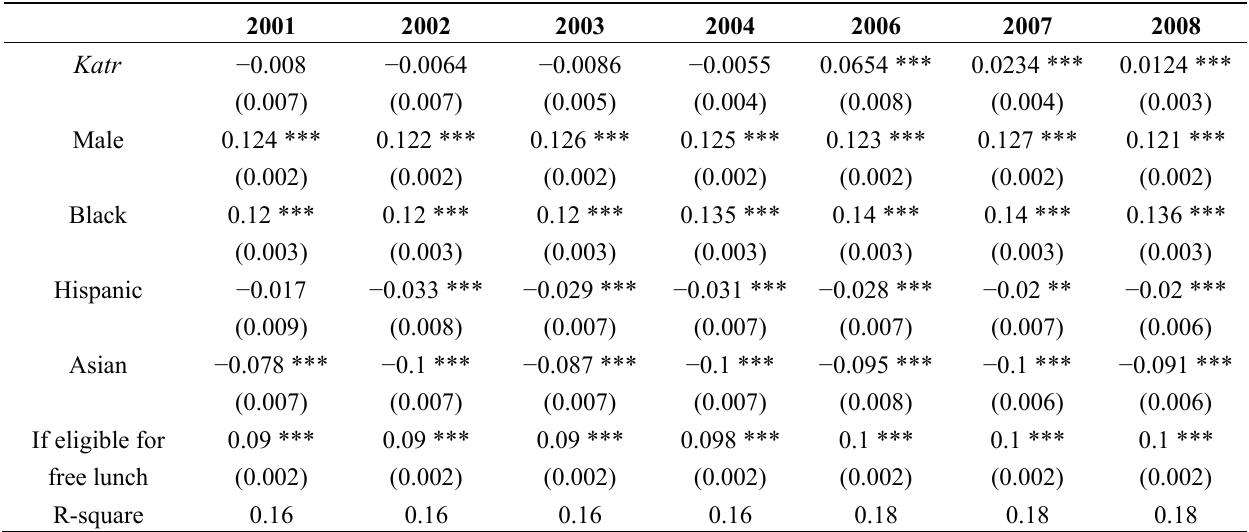
Table 3. Displaced students’ relative likelihood of infraction across